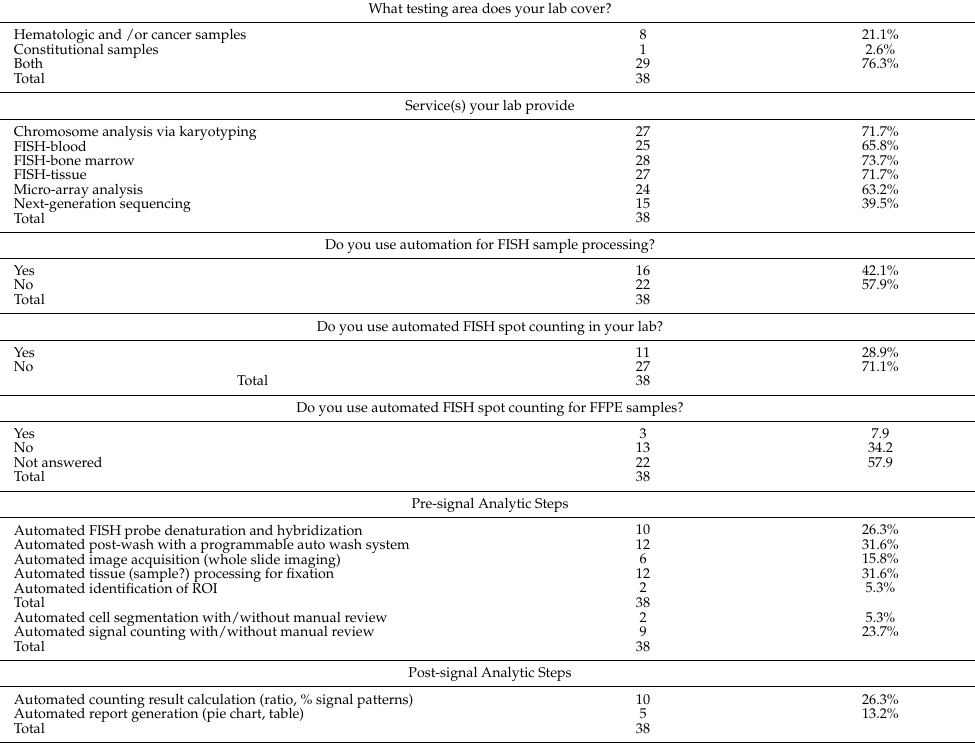
Table 1. A summary of survey questions and responses to